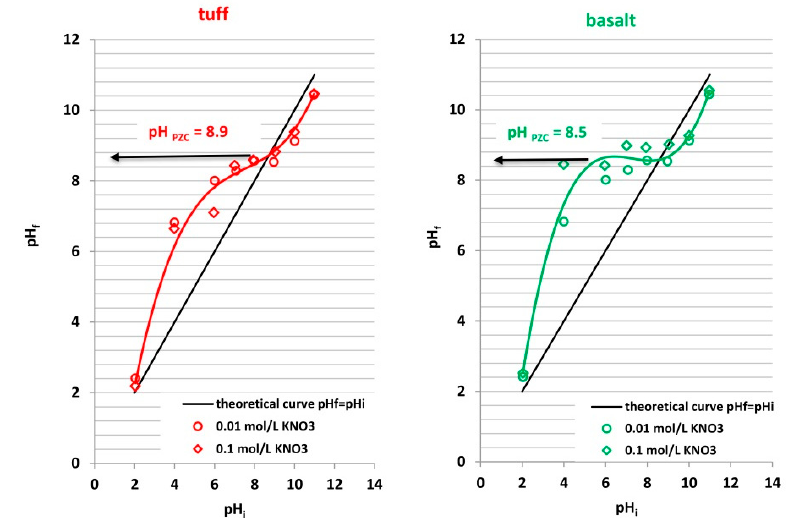
Figure 2. Determination of pH PZC of tuff and basalt in KNO 3 solutions.